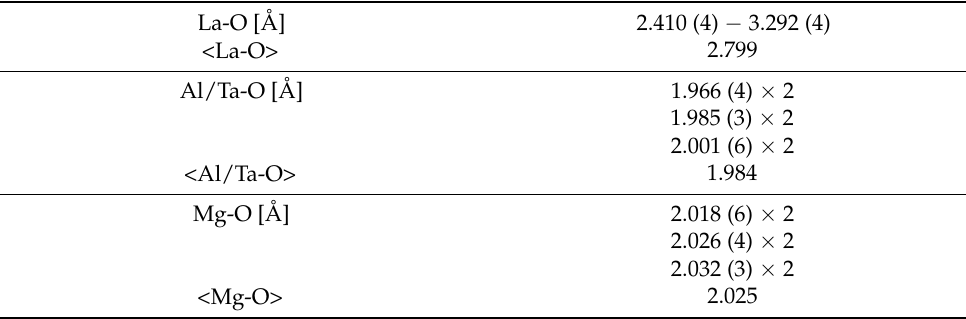
Table 2. Selected interatomic distances and angles of